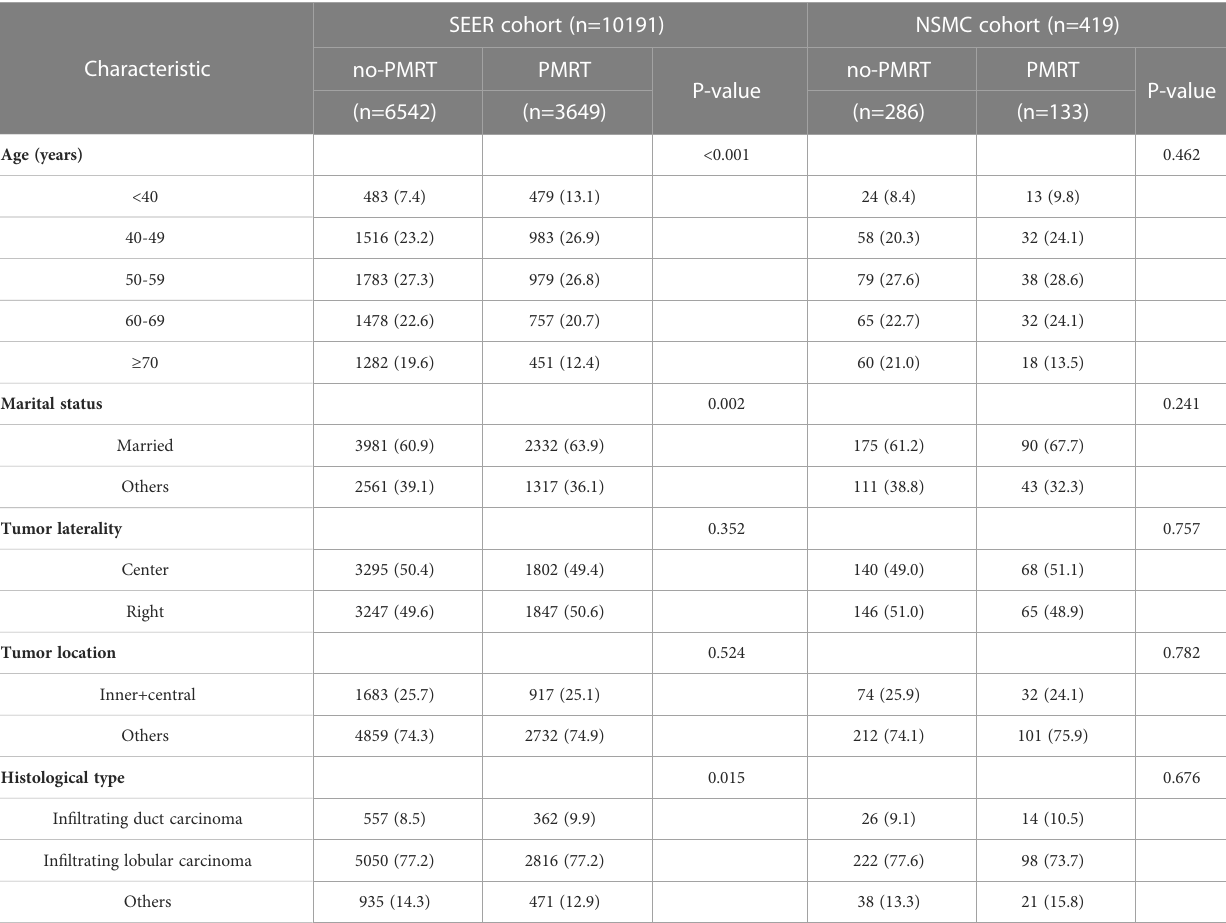
TABLE 1 Baseline characteristics of the SEER and NSMC cohorts in T1-2N1 breast